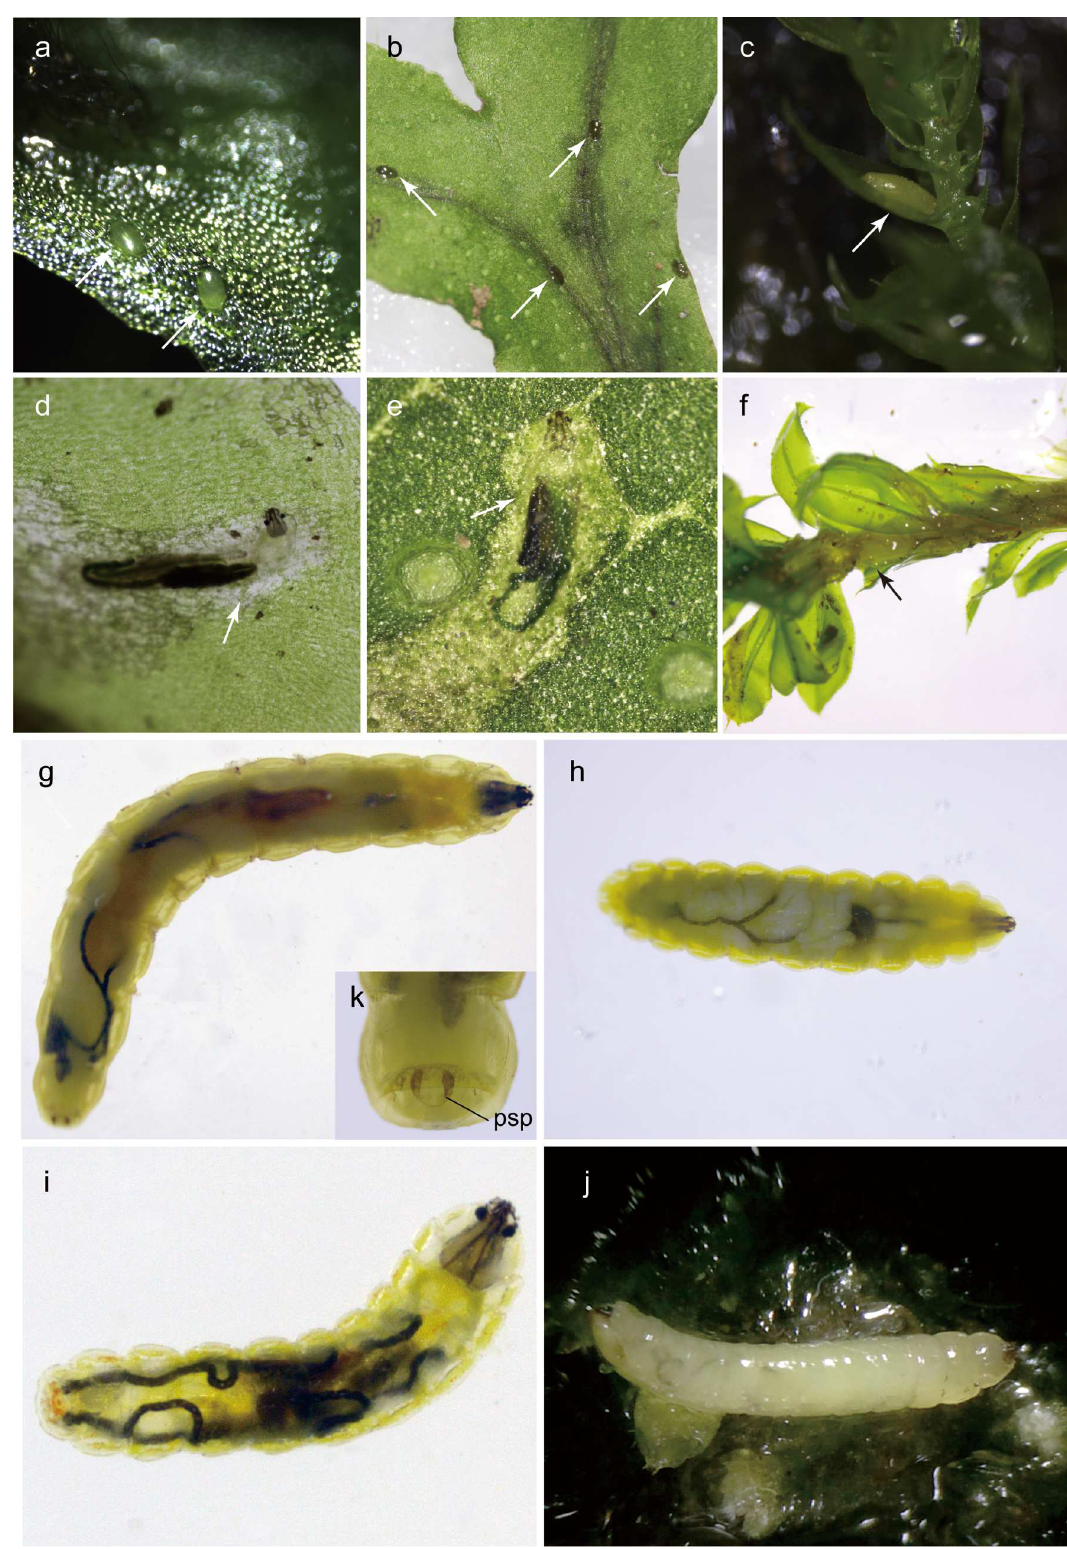
PLOS ONE | DOI:10.1371/journal.pone.0165808 November 3,